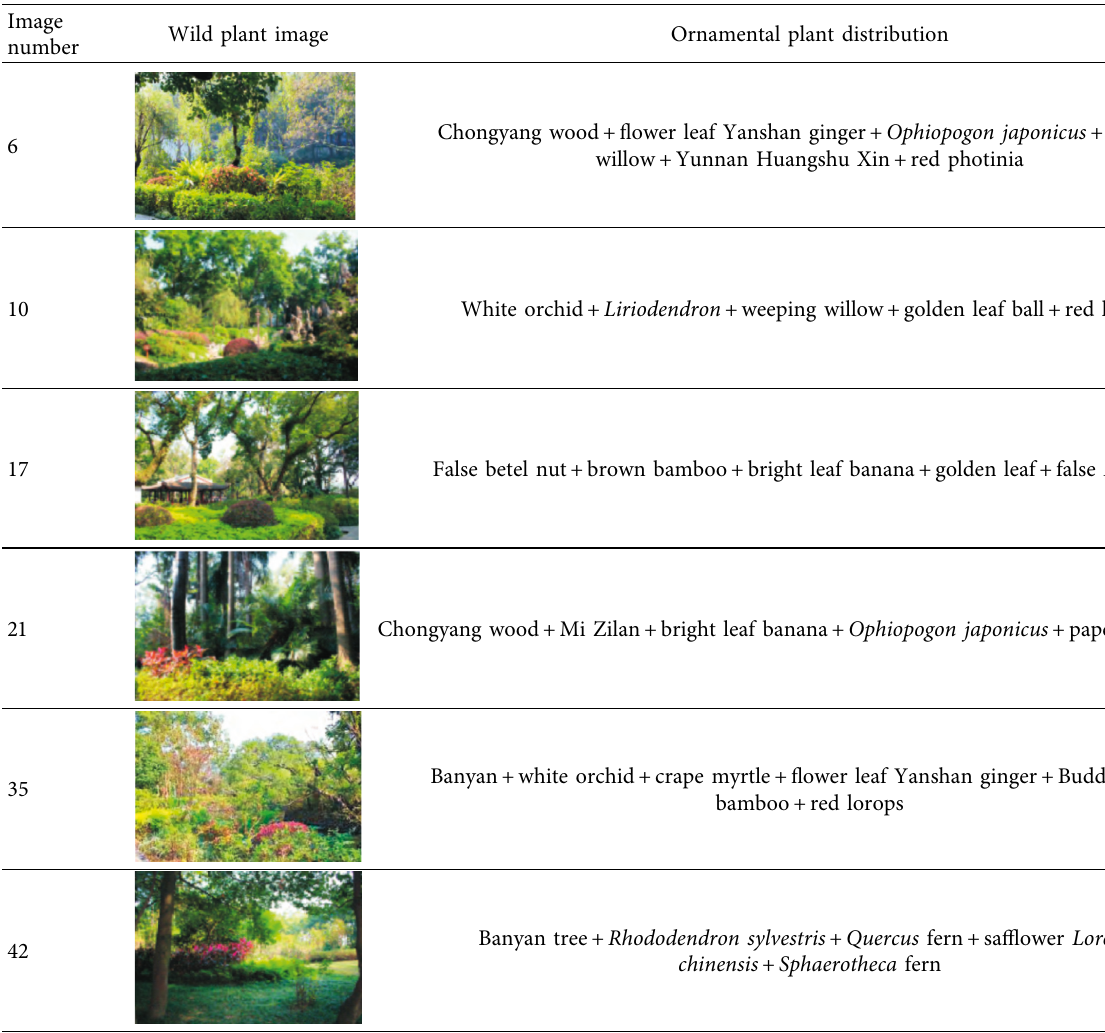
Figure 4: Picture of wild ornamental Table 1: Distribution of wild ornamental plants in different regions.